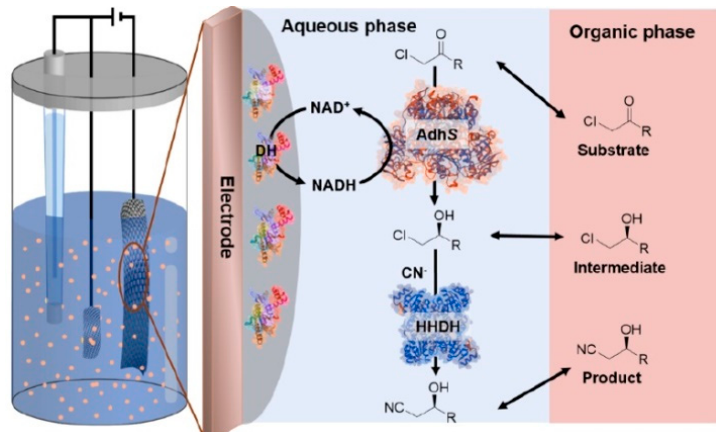
Figure 12. Schematic diagram of the biphasic bioelectrocatalytic reaction cascade for the synthesis of (R)-ethyl-4-cyano-3-hydroxybutyrate. Reprinted from [181] Copyright (2020) with permission from American Chemical Society.